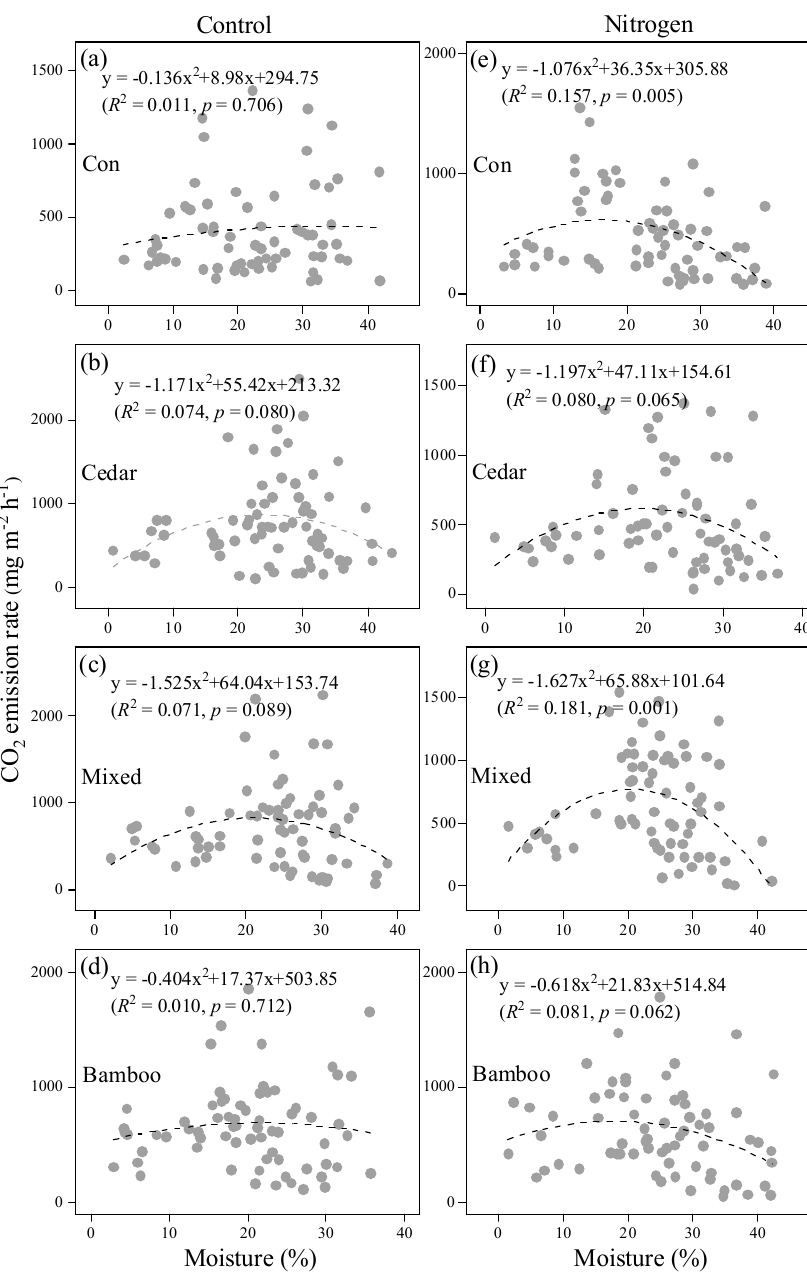
Figure 5. Correlations between soil CO 2 emission rate (mg m − 2 h − 1 ) and soil moisture (%) with different nitrogen (control vs. nitrogen) and fine root litter (con, a and e; cedar fine root, b and f; mixed fine root litter, c and g; bamboo fine root, d and h) treatments Goodness of fit of the data to the quadratic equation ( R 2 ) and p values are shown.